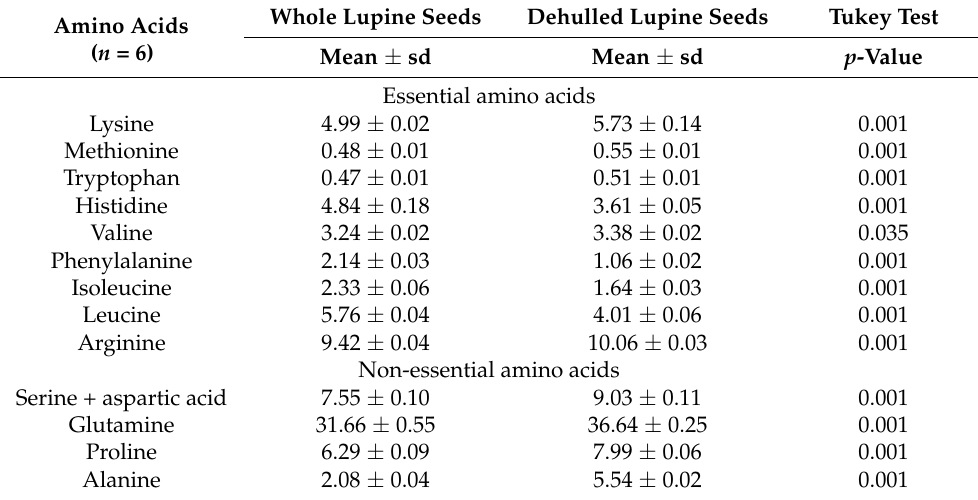
Table 4. Influence of dehulling L. albus (cv. Amiga) seeds on the amino acids content (g/16 g N).